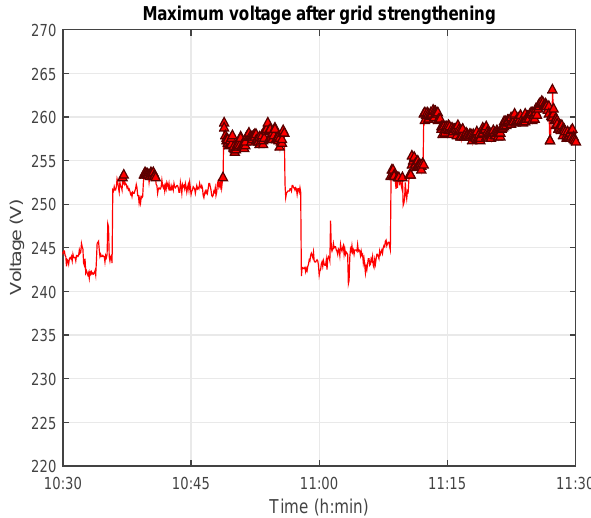
Figure 5. Maximum voltage behavior after the grid strengthening during one hour. Swells are marked with red upwards ‐ pointing triangles.